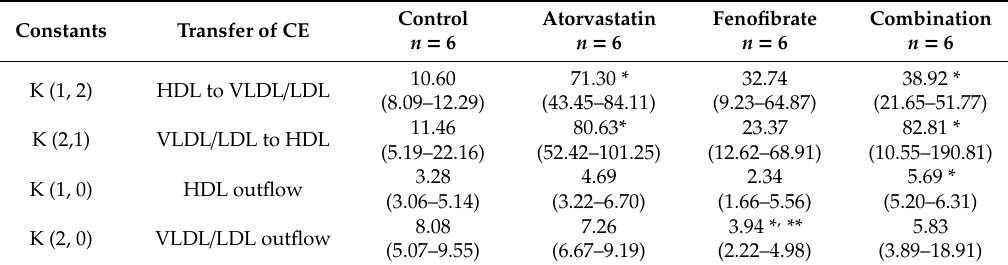
Table 3. Transfer rates of cholesteryl esters between